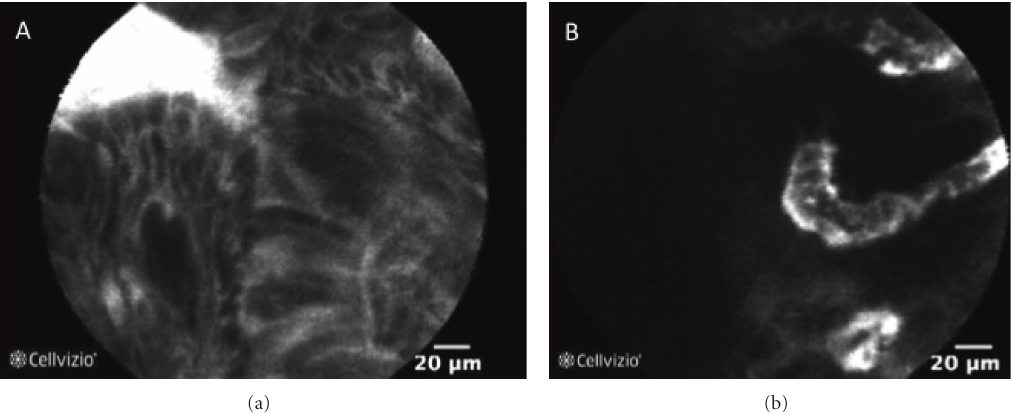
Figure 4: p-CLE fluorescein sodium 10% imaging of dysplastic epithelium in ulcerative colitis. (a) the architectural pattern of crypt is irregular, with epithelial thickness, villiform structures, and “dark” epithelial border. (b) the vessel architecture shows tortuous and dilated